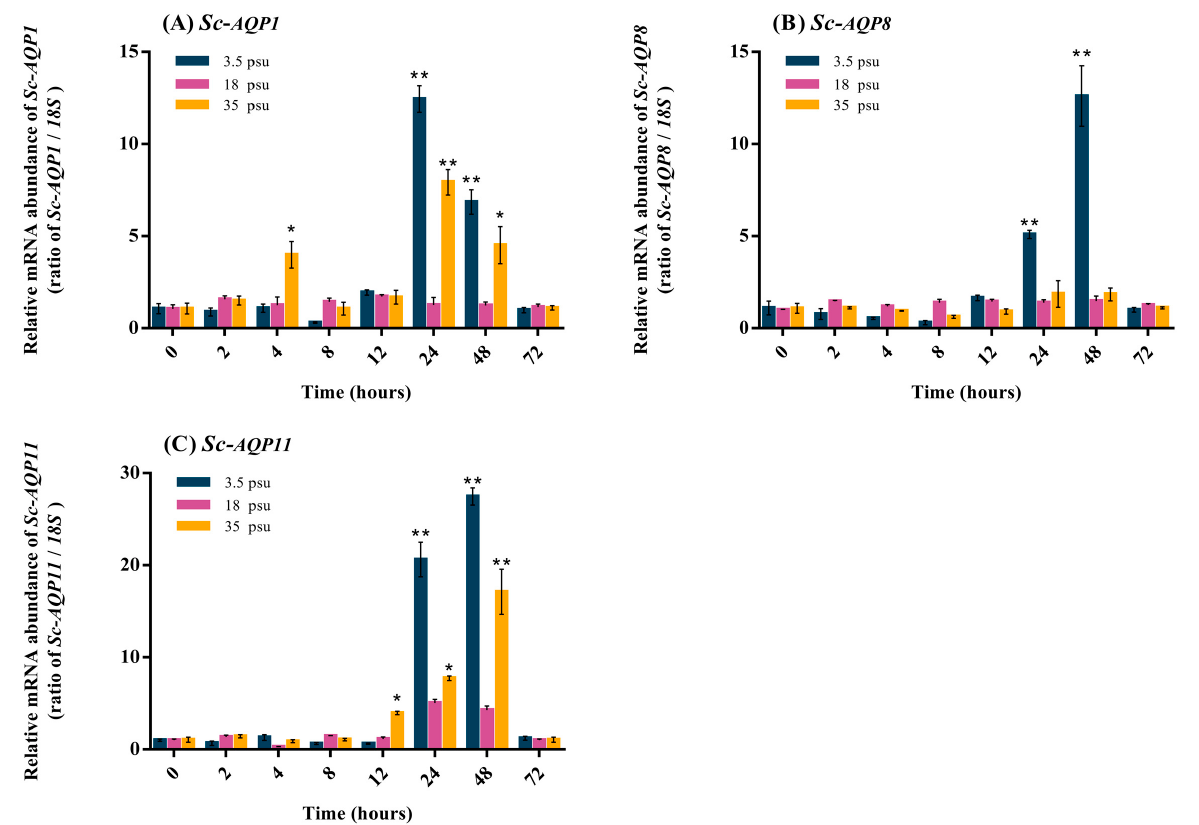
Figure 6. Temporal expressions of the Sc-AQP1 ( A ), Sc-AQP8 ( B ), and Sc-AQP11 ( C ) after salinity challenge of 3.5, 18, and 35 psu. Vertical bars represent the mean ± SE ( n = 15). Data were statistically analyzed by using one-way ANOVA followed by the LSD test. The asterisks (*) show a significant difference between the salinity challenge group (3.5 and 35 psu) and the control group (18 psu) at each sampling time. Note: * p < 0.05; ** p < 0.01.